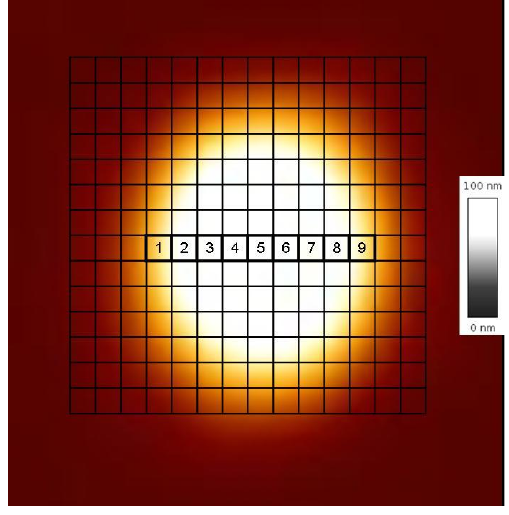
Figure 8. JPK force mapping tool. Every square represents a force curve with its extended and retracted part. For the calculation the number-marked squares were